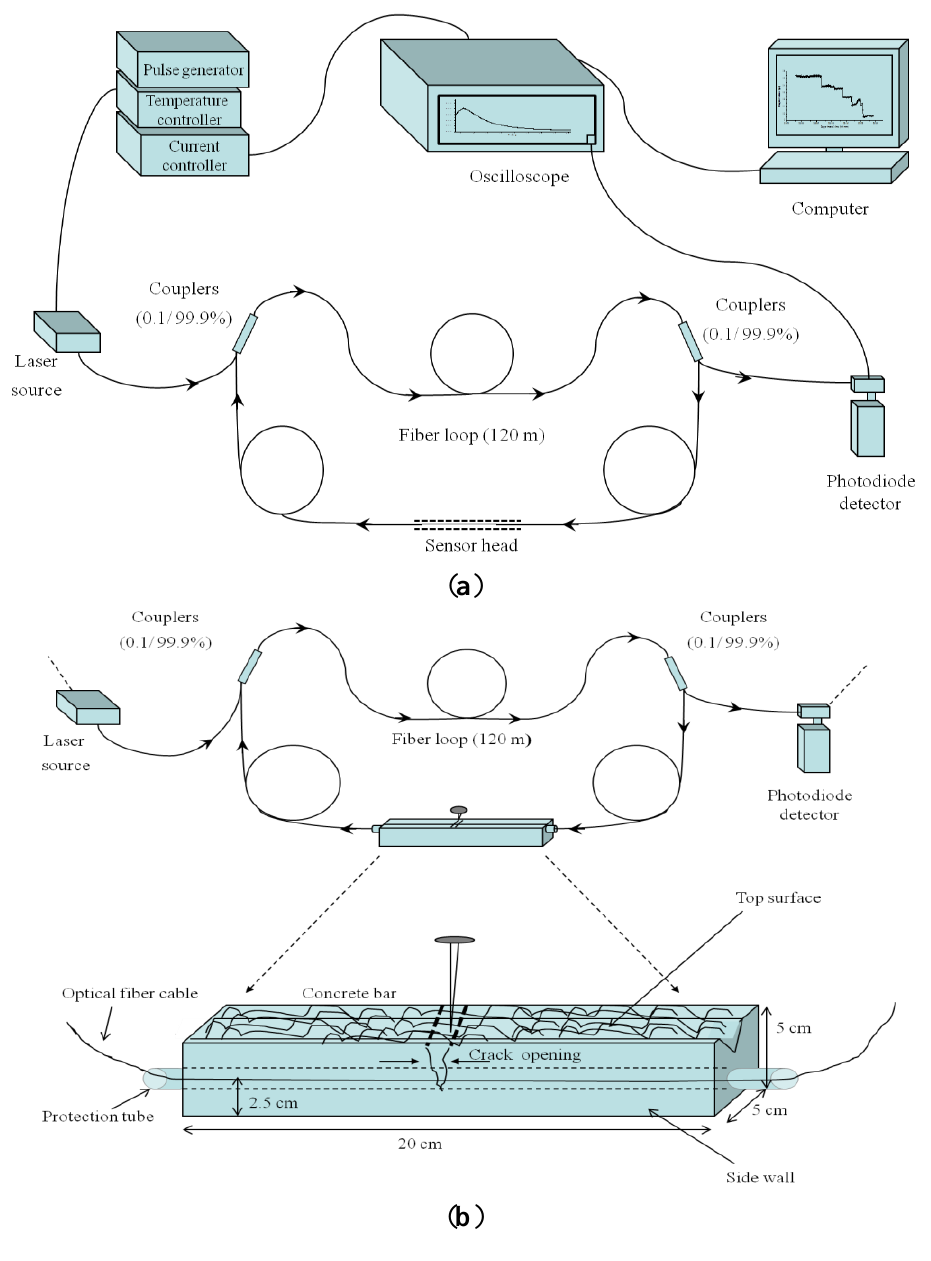
Figure 1. ( a ) Schematic of the FLRD sensor system. ( b ) Sensor configuration for crack sensing in concrete